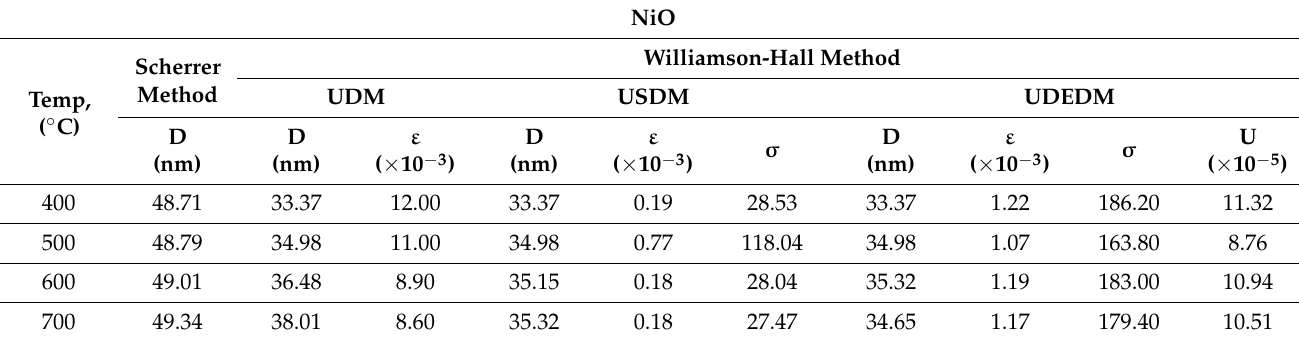
Table 2. Summary of crystallite size (D), lattice strain ( ε ), deformation stress ( σ ) and energy density (U) calculated using a different model for NiO at temperatures of 400 ◦ C to 700 ◦ C.